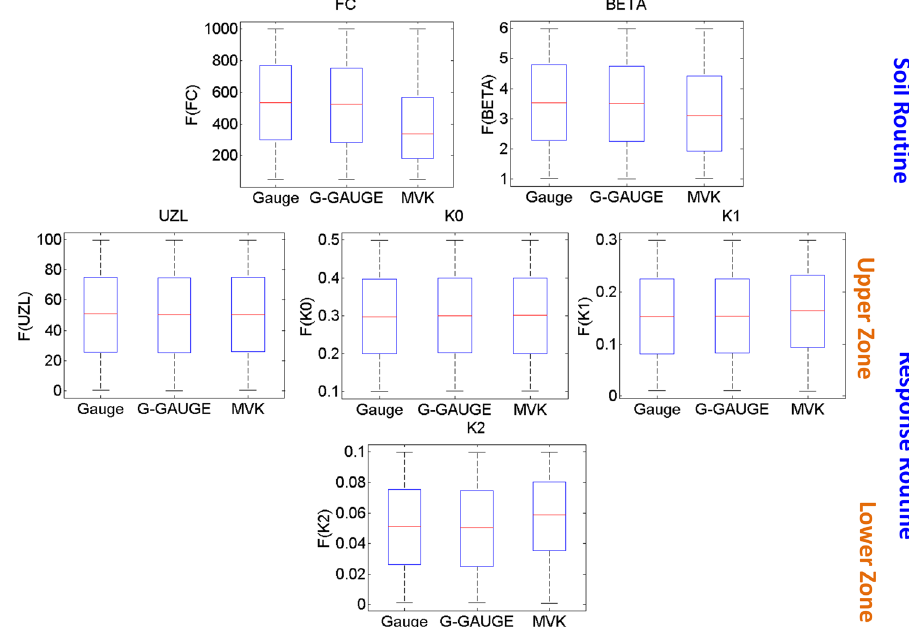
Fig. 8 Box plots of 6